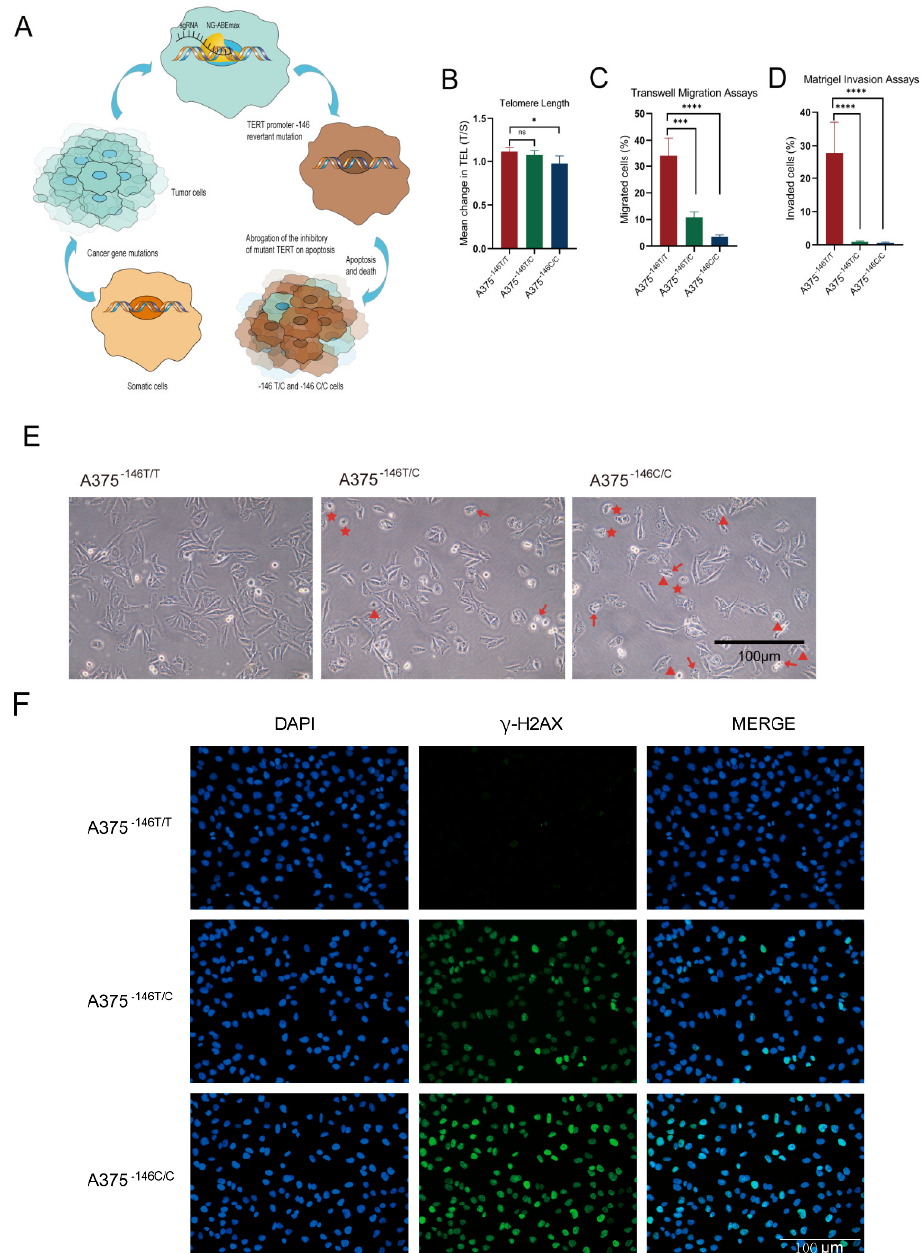
Figure 2. TERT -146 T>C reduces telomere length, migration and invasion of A375 -146T/C and A375 - 146C/C . ( A ) Schematic diagram of somatic cell carcinogenesis and revertant mutation; ( B ) telomere length measurements. DNA extraction from cells for Q-PCR. Mean change in telomere length (T/S) of A375 -146T/C and A375 -146C/C . Reference cell line: HepG2; ( C ) cell migration assay. Migration and invasion tests measured by Transwell; ( D ) cell invasion assay; ( C , D ) the vertical coordinate indicates the percentage of migrated or invaded cells. Student’s t -test. * p < 0.05, *** p < 0.001, **** p < 0.0001; ( E ) changes in the morphology of A375 -146T/C and A375 -146C/C compared to A375 -146T/T (triangles: cellu- lar shrinkage. pentagons: condensation and margination of chromatin. Arrows: ruffling of the plasma membrane) (original magnifications ×20. Scale bar, 100 µm); ( F ) DNA damage assay. Cells were cultured in 12-well plates and DNA damage was detected using γ-H2AX immunofluorescence assay. γ-H2AX immunofluorescence assay of A375-146T/T, A375-146T/C, and A375-146C/C. The green fluo- rescence indicates the amount of intracellular γ -H2AX, blue indicates DAPI staining. All results were obtained from the mean of at least three independent experiments. 2.2. Figure 6O In the original publication, there was a mistake in Figure 6O as published. VDAC1 is located in the outer mitochondrial membrane and ANT is located in the inner mitochon- drial membrane. We believe that our previous image was not rigorous enough, so we have re-edited it. The corrected Figure 6O appears below. 3.3. Off-Target Analysis Many studies have shown that off-target effects are not only related to sgRNA but also to experimental conditions [46]. Off-target effects have been an important issue